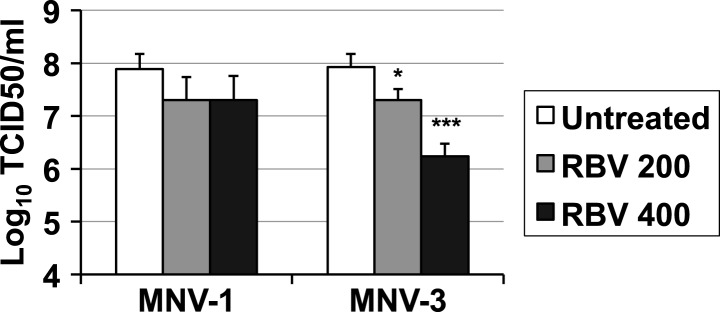
Reduced virus yields in ribavirin-mutagenised populations.RAW264.7 cells were infected with MNV-1 or MNV-3 recovered after 5 passages in the absence (untreated) or presence of ribavirin (200 or 400 μM) with the exception of 400 μM ribavirin-treated MNV-3 where passage 2 was used due to insufficient virus titres in subsequent passages. Infections were performed at an MOI of 0.01. After adsorption (1 hr at 37°C), virus inoculum was removed and complete media added to infected cultures. Infected cells were then incubated as mentioned in ‘Materials and methods’ for a total of 17 hr before freezing.